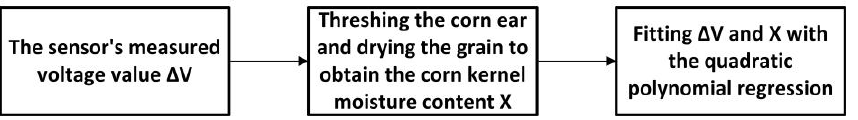
Figure 5. Rapid nondestructive process for measurement of the moisture content of the kernels of a corn ear.